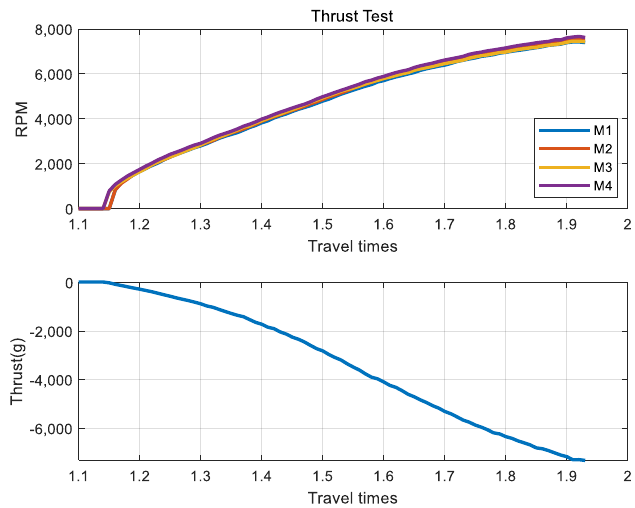
Figure 11. The experiment D result of the actuator assembled with motor and propeller.